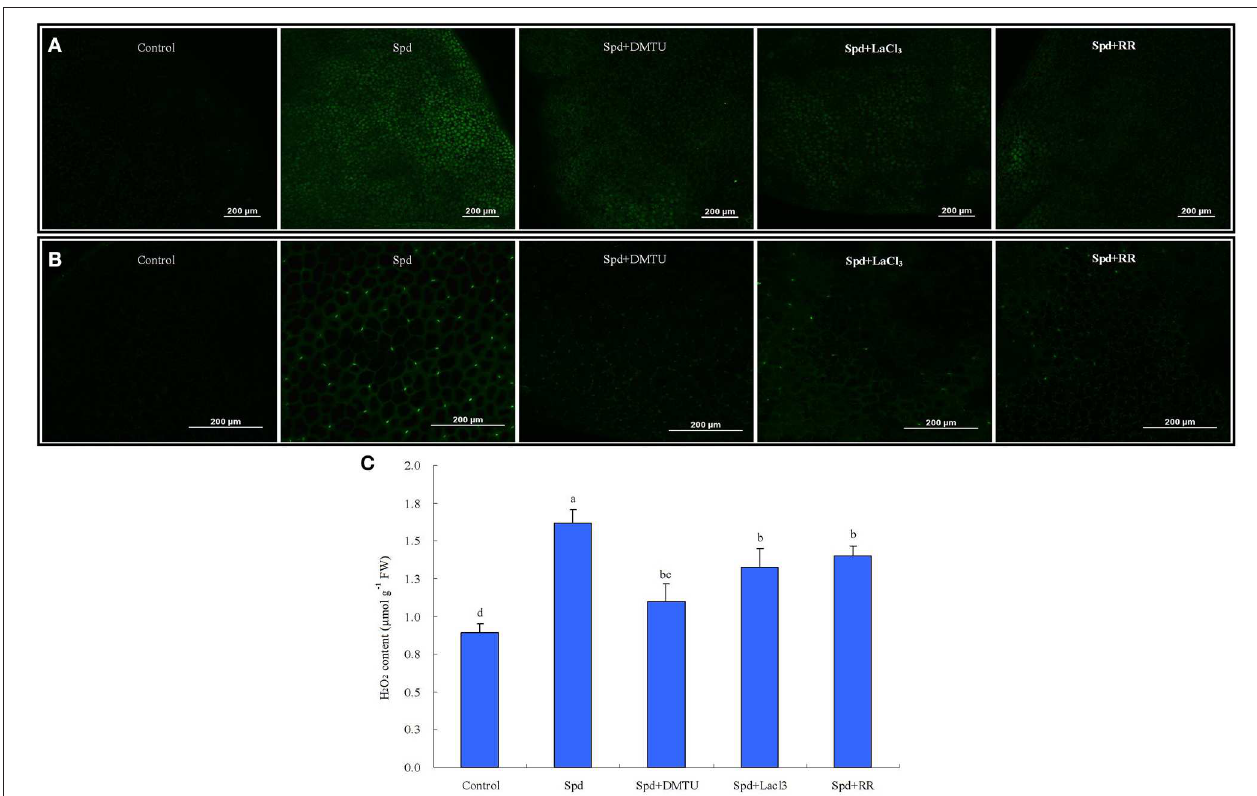
FIGURE 14 | Cytosolic free Ca 2 + (A) and H 2 O 2 accumulation (B–C) in response to spermidine (Spd), H 2 O 2 scavenger or calcium (Ca 2 + ) channels blockers. The detached leaves of white clover were pre-treated with distilled water for 1h to eliminate wound stress and then treated for 30min as follows: 1, distilled water (control); 2, 20 µ M Spd; 3, 20 µ M Spd + 5mM dimethylthiourea (DMTU); 4, 20 µ M Spd + 1mM LaCl 3 ; 5, 20 µ M Spd + 50 µ M ruthenium red (RR) and followed by incubation with Ca 2 + -sensitive fluorescent probe Fluo-3-AM or H 2 O 2 -sensitive fluorescent probe H 2 DCFDA for 30min. Images are visualized using confocal laser scanning microscopy (CLSM). Means of four independent samples are presented. Bars represent standard errors. The same letter indicates no significant difference (LSD) at P <